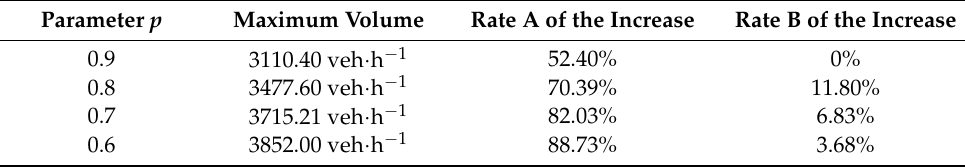
Table 3. Maximum volumes of the traffic flow affected by the GPV